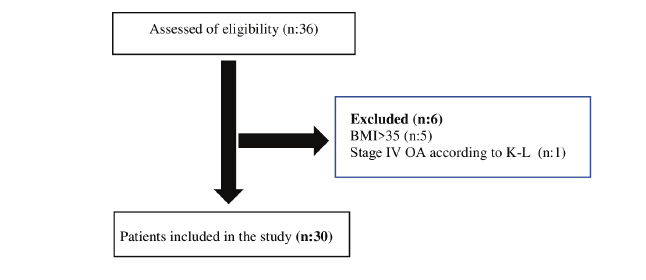
Figure 1 - Flow chart of the study. Figure 2 - Active range of motion measurement of the